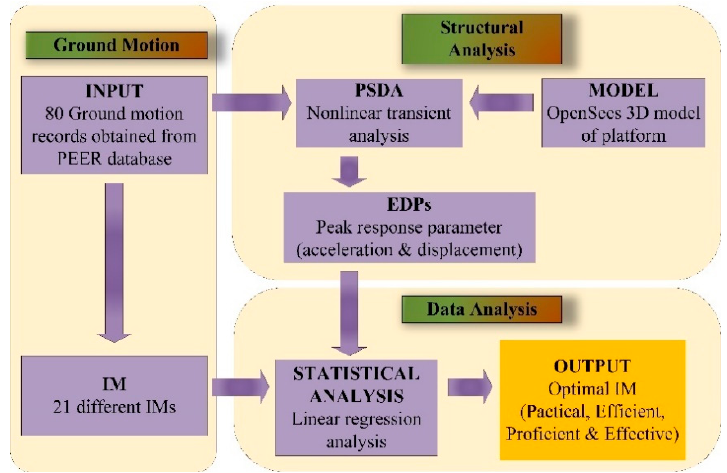
Figure 5. Outline of the methodology of optimal PSDM evaluation.